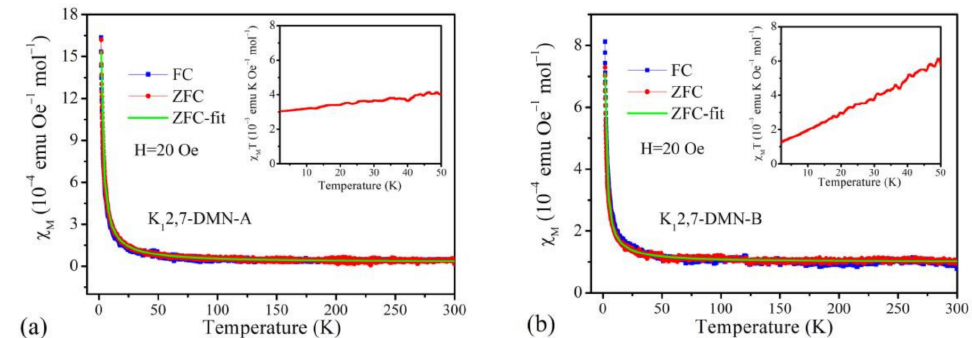
Figure 1. ( a ) The relationship between molar magnetic susceptibility ( χ M ) and temperature of potassium intercalated 2,7-DMN-A sample. The inset shows the χ M T − T curves of this sample. ( b ) The relationship between molar magnetic susceptibility and temperature of potassium intercalated 2,7-DMN-B sample. The inset shows the χ M T − T curves of this sample.